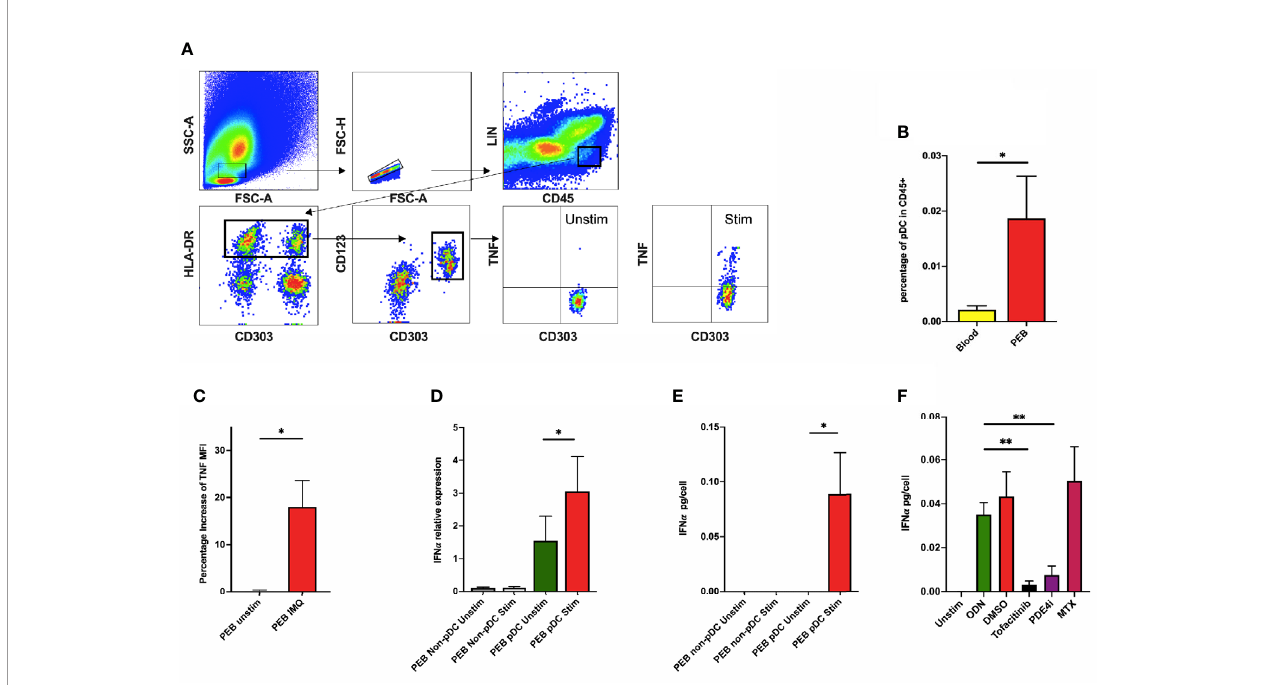
FIGURE 1 | (A) Peri-entheseal bone (PEB) was separated from soft tissue and digested and pDC phenotype was con fi rmed using fl ow cytometry. Following stimulation with ODN, intracellular TNF was quanti fi ed using fl ow cytometry (last 2 graphs in A ). (B) Flow cytometry showed that entheseal pDCs were more numerous than blood pDCs (1.86 ± 0.77% vs 0.21 ± 0.07% of CD45+ cells, n=5, p=0.008). (C) Mean percentage increase of TNF MFI also showed a signi fi cant increase after stimulation with imiquimod (18.03% vs 0.18%, n=4, p=0.047). Secretion of IFN a from pDCs after ODN stimulation was demonstrated by RT-PCR (n=8, D ) and ELISA (n=6, E ) respectively. The effect of different drugs on the expression of IFN a from entheseal cells was compared (n=4, F ). IFN a from ODN stimulated: 0.035 ± 0.011 pg/cell, co-incubated with Tofacitinib: 0.003 ± 0.003 pg/cell, co-incubated with PED4i: 0.008 ± 0.008 pg/cell, co-incubated with MTX: 0.050 ± 0.031 pg/cell. LIN: lineage markers (CD3, CD56, CD19, CD14, CD11c), MFI, median fl uorescence intensity; IMQ, imiquimod; Unstim, unstimulated; stim, stimulated. * p < 0.05, ** p <